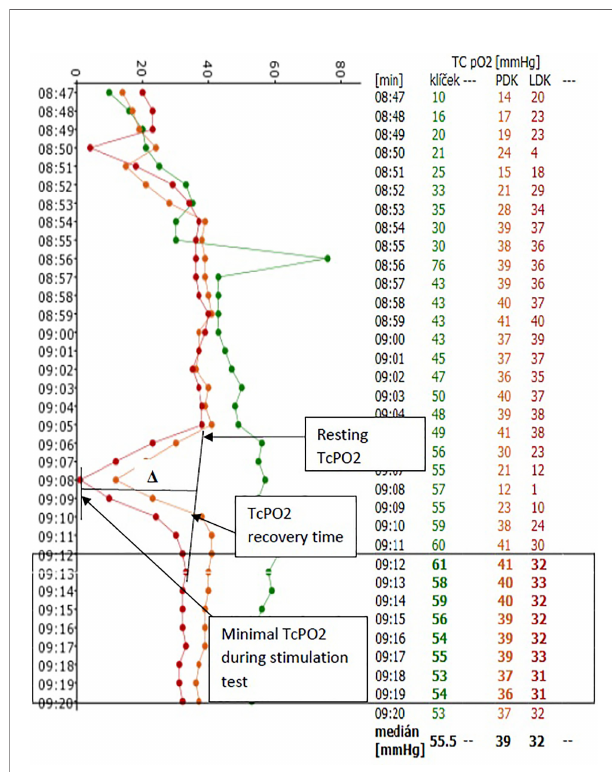
FIGURE 3 | Record of TCPO2 measurement during stimulation test Evaluated parameters: Resting TcPO2; maximal decline of TcPO2 during stimulation test, minimal TcPO2 during stimulation test; TcP02 differences in absolute numbers ( △ =resting TcPO2 minus minimal TcPO2 during the stimulation test) and in percentages; TcPO2 recovery